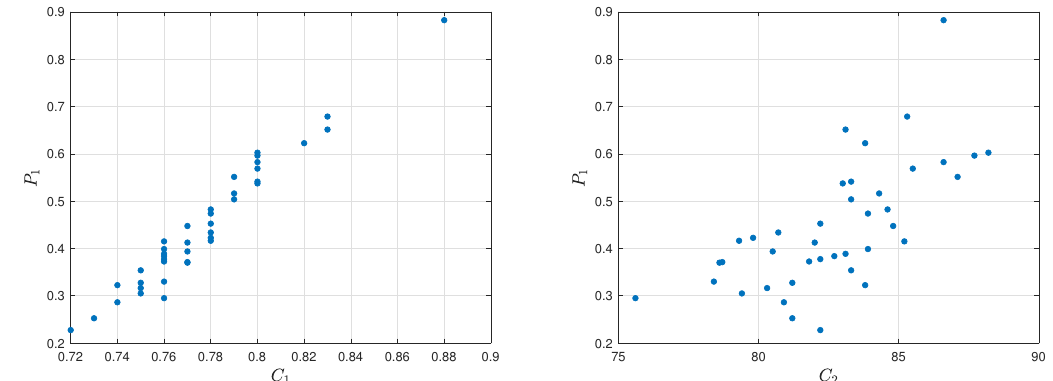
Figure 22. The relation diagram of Average kills per round ( C 1 ) for assessment P 1 ( left side ) and Average damage per round ( C 2 ) for assessment P 1 ( right side ).